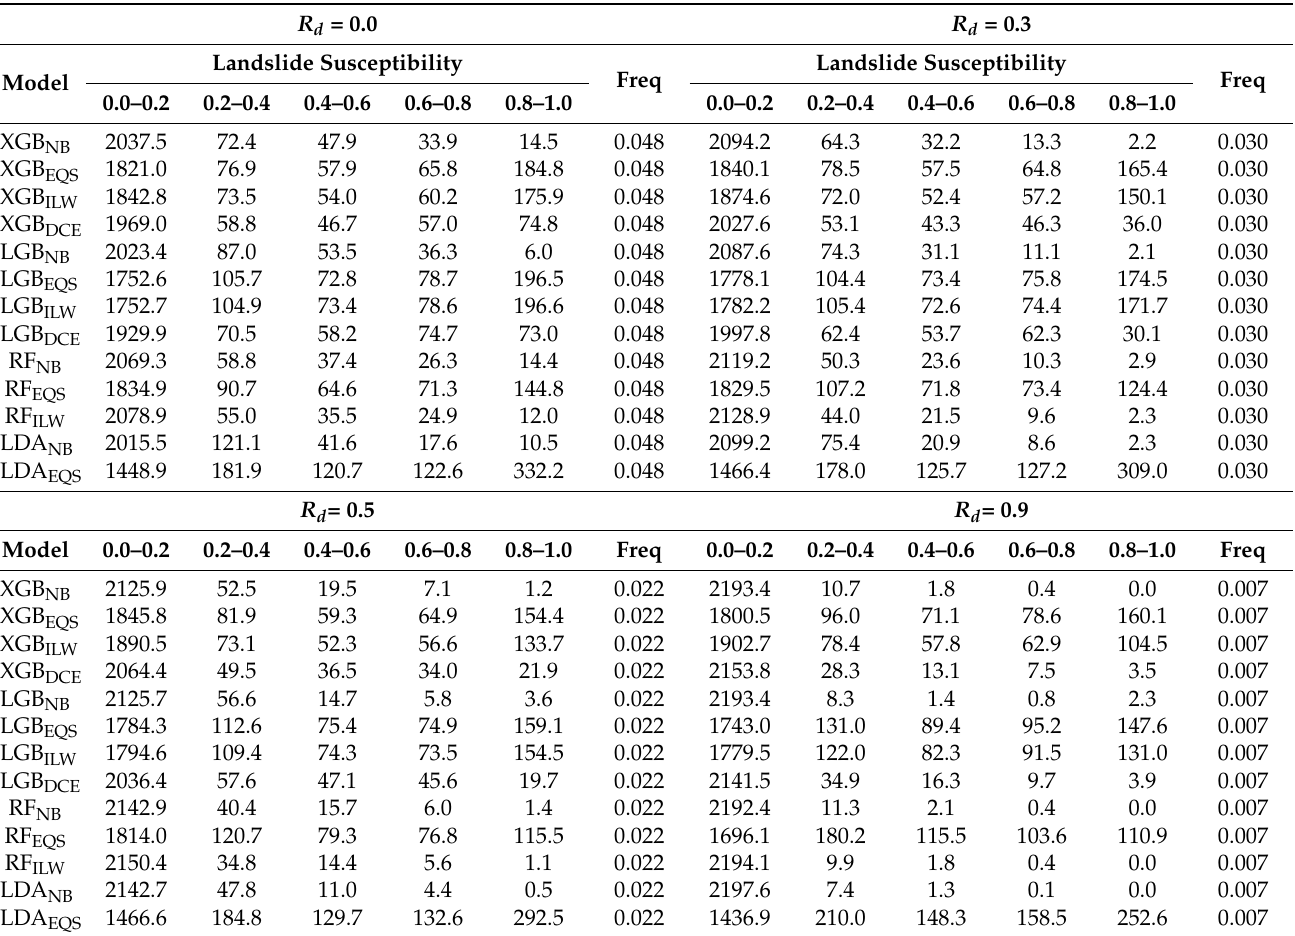
Table 5. Statistical analysis of the number of cells (unit: thousand) in the generated landslide susceptibility maps for every